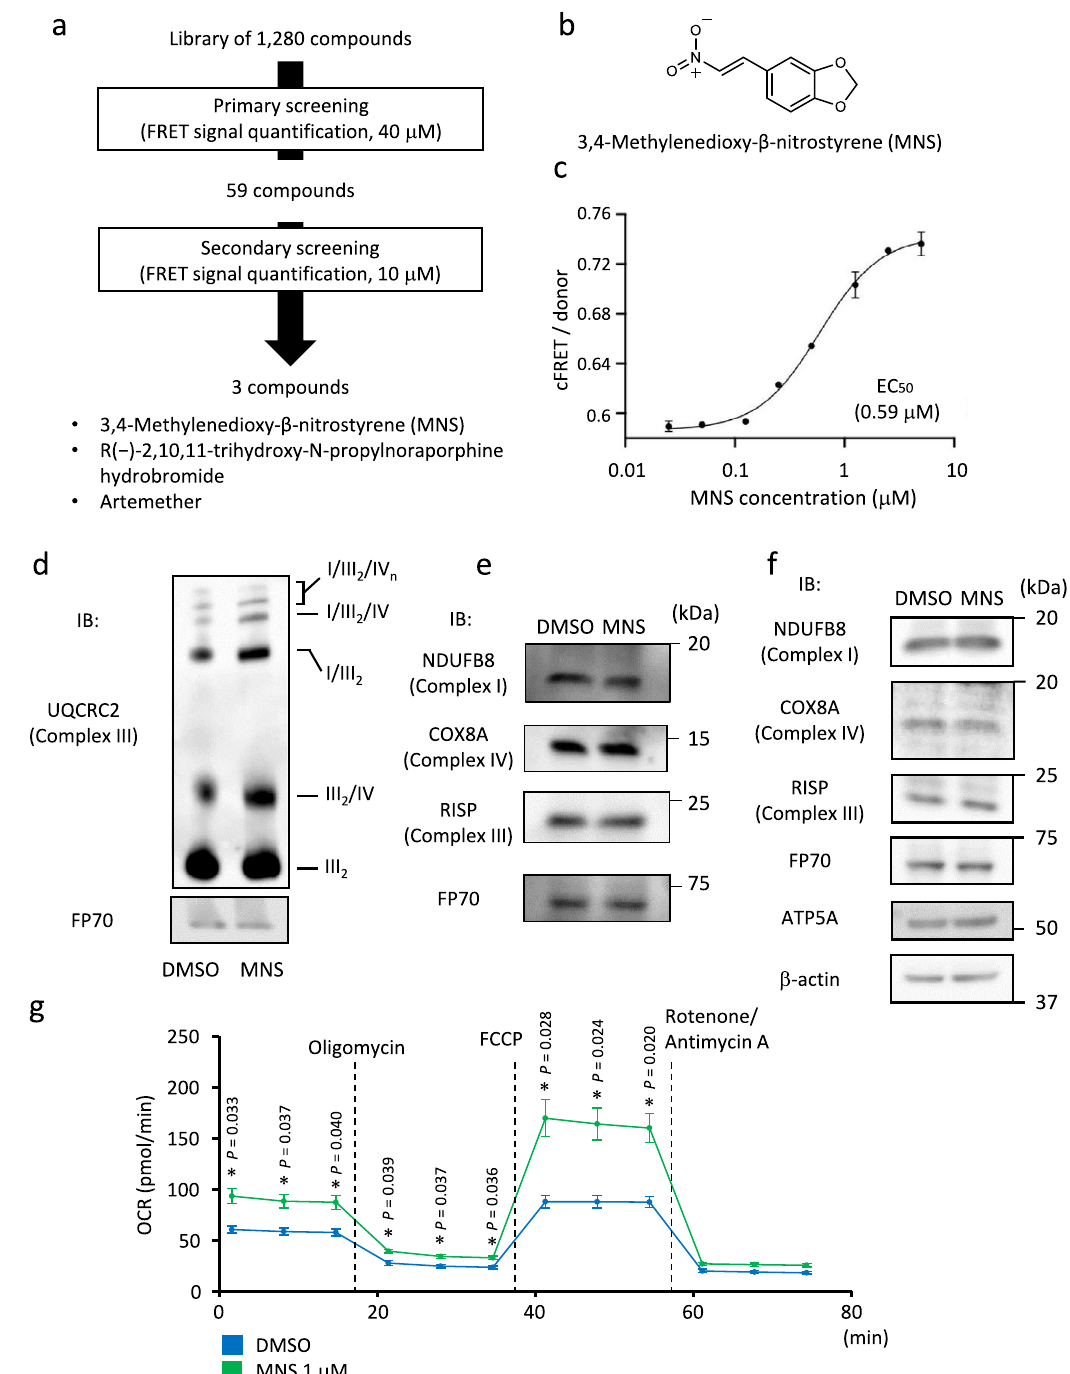
Fig.3|3,4-methylenedioxy- β -nitrostyrene(MNS)wasidenti fi edasacompound inducing mitochondrial respiratory chain supercomplex formation using a chemicallibraryscreenwithFRETimaging.a Schemeofthemedium-throughput screenproceduresusingimagingcytometer.CompoundsthatinducedhighcFRET/ donorvalueinC2C12cellsstablyco-expressingNDUFB8-AcGFPandCOX8A-DsRed- Monomer were selected for further analysis. b Chemical structures of MNS. c cFRET/donor ratio of C2C12 cells stably co-expressing NDUFB8-AcGFP and COX8A-DsRed-MonomertreatedbydifferentconcentrationsofMNSfor24h.Data are presented as means±SE of three wells for each treatment. EC 50 , half maximal effective concentration. d BN-PAGE of mitochondrial proteins from C2C12 cells treated with MNS (1 μ M) or DMSO for 24h. Positions corresponding to indicated mitochondrial supercomplexes and dimerized complex III (III 2 ) are indicated.